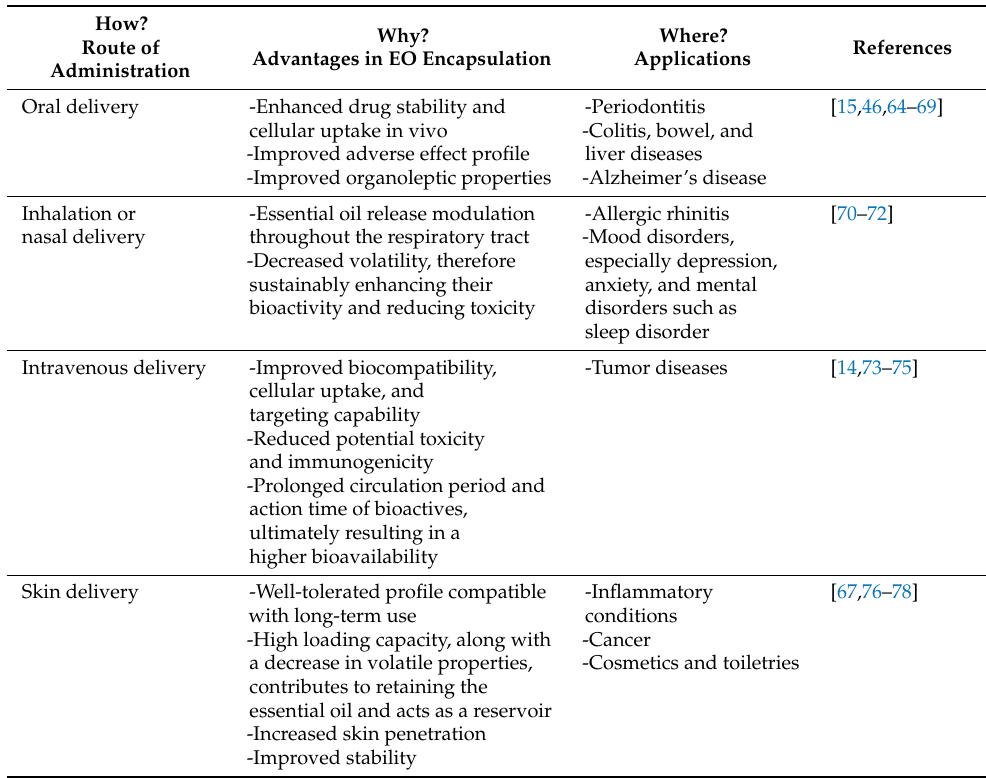
Table 2. Route of administration, advantages, and applications of essential oils encapsulation in plant